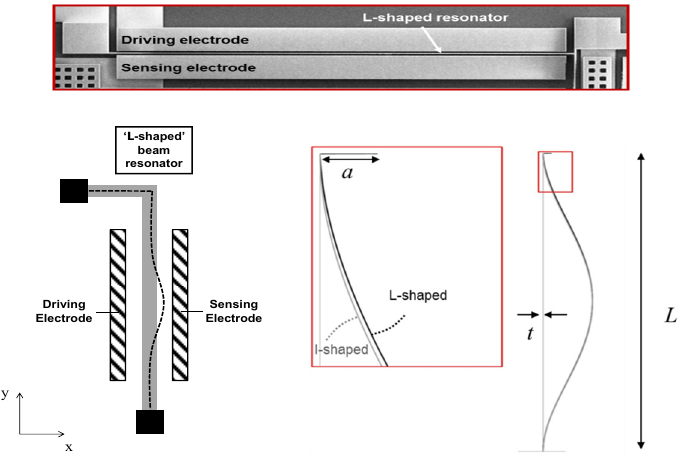
Figure 1. L-shaped Figure 1. L-shaped micro-resonator.